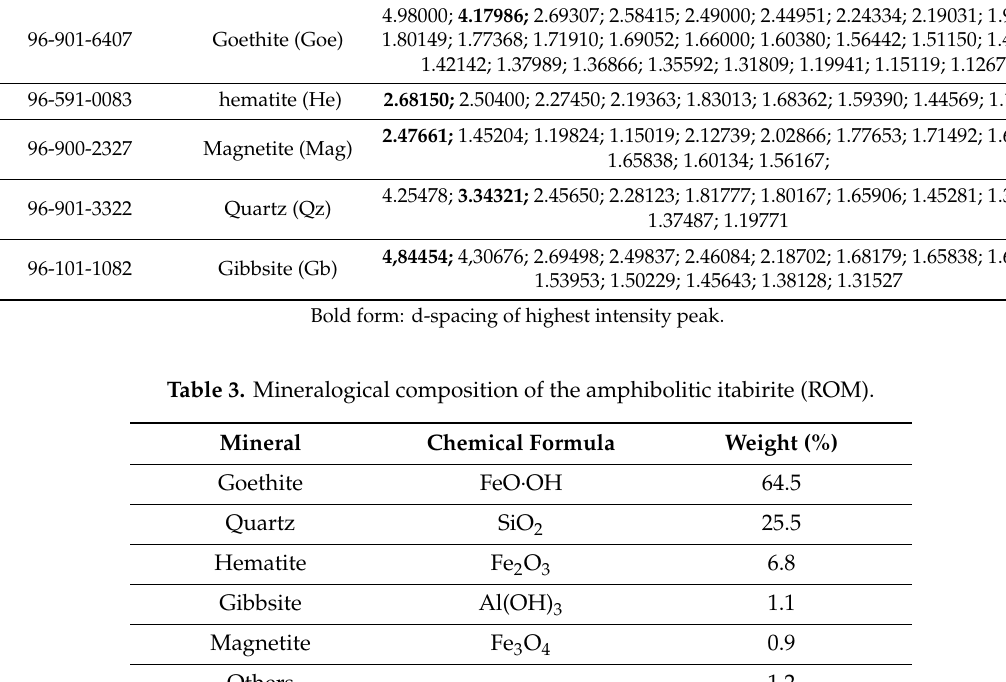
Table 2. X-ray di ff raction patterns reference PDF 2 used to identify the minerals in the di ff raction pattern of the size fraction − 45 µ m of the amphibolitic itabirite (ROM). PDF-2 Ref. Code